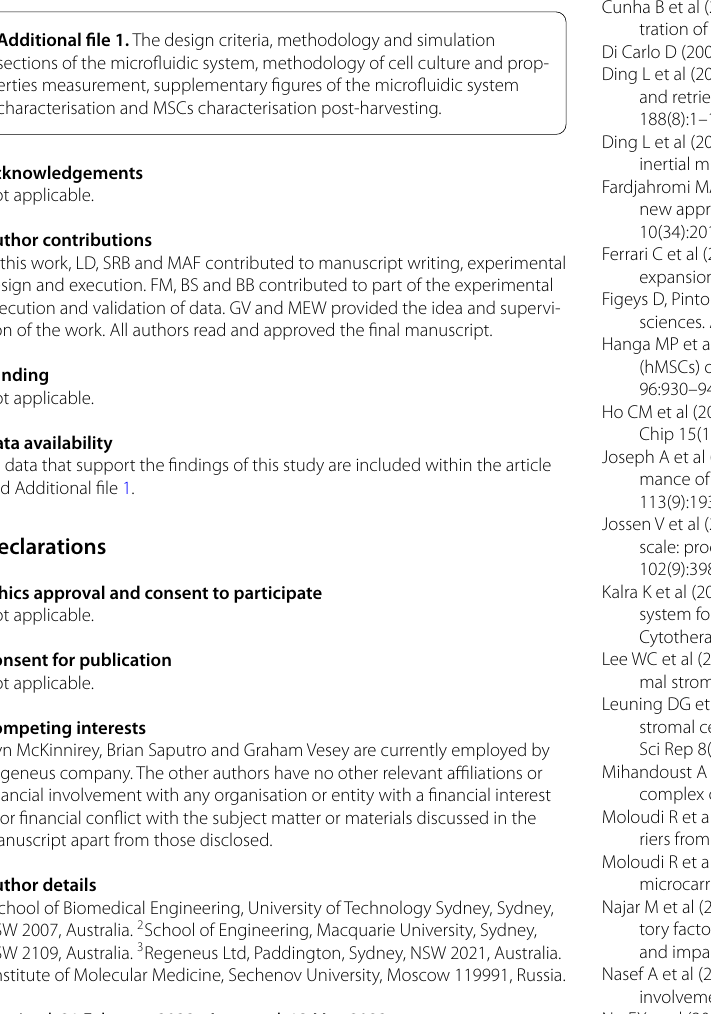
Figeys D, Pinto D (2000) Lab-on-a-chip: a revolution in biological and medical sciences. Anal Chem